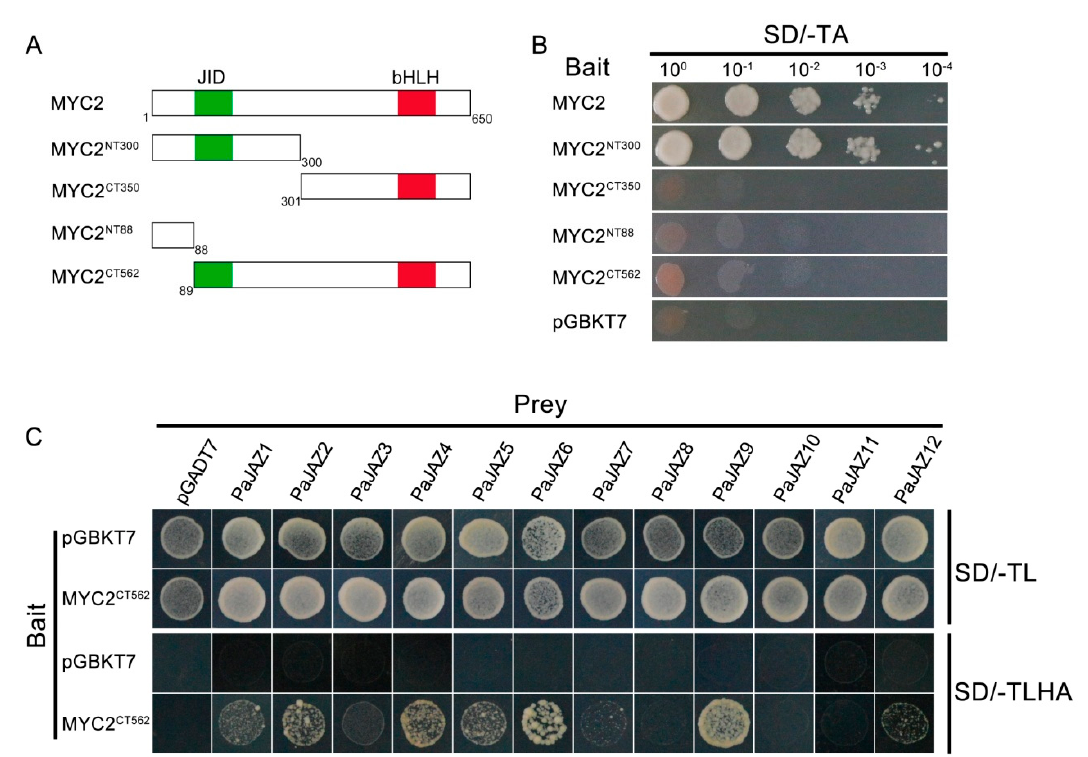
Figure 8. ( A ) Schematic diagrams showed the truncated derivatives of MYC2. The diagrams displayed the conserved JAZ-interaction (JID) domain (green) and basic helix-loop-helix (bHLH) domain (red). The first and the last amino acids of the truncated derivatives are presented in numbers below. ( B ) The autoactivation test of full-length MYC2 or several truncated derivatives. Yeast cell AH109 carrying a recombinant bait vector was plated on solid synthetic dropout medium lacking Trp (SD / -TA) to test autoactivation. ( C ) Y2H assays to test the interaction between PaJAZ proteins and transcription factor MYC2. A combination of recombinant pGBKT7-MYC2 CT562 (bait) and various pGADT7-PaJAZ constructs (prey) was co-transformed into yeast strain AH109 and further plated on SD medium lacking Trp and Leu (SD / -TL) as a control or SD medium lacking Trp, Leu, His, and Ade (SD / -TLHA) to test protein interactions.